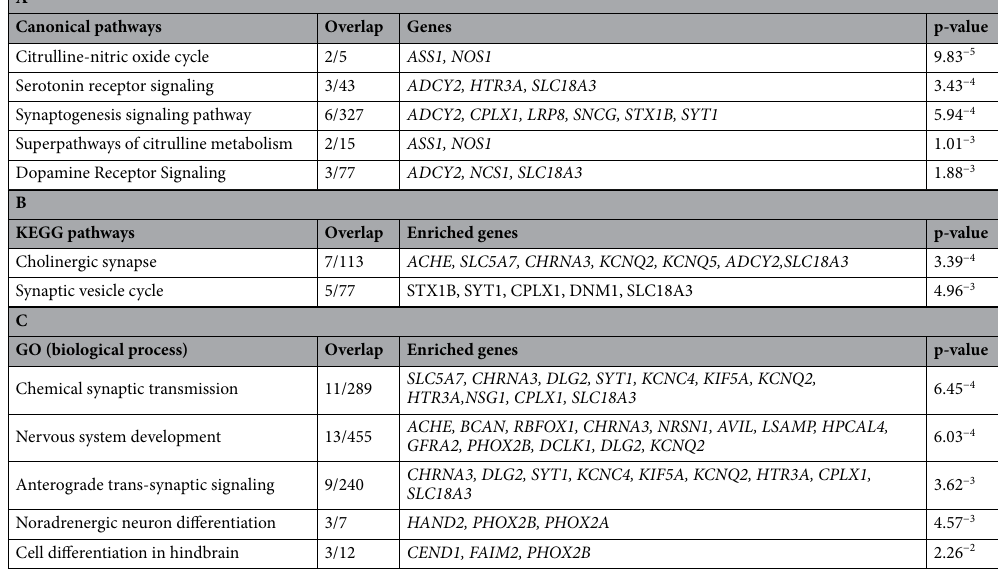
Table 2. Pathway analysis of the 95 differentially expressed genes between islets of pregnancy Prlr +/− and βPrlR +/− mice. (A) Canonical pathways that are differentially expressed in Prlr +/− versus βPrlR +/− mice, as identified by the Ingenuity Pathway Analysis. (B) KEGG pathway analysis of the 95 genes (from Table 1) identified 2 significantly enriched pathways (https:// maaya nlab. cloud/ Enric hr/ enrich#). (C) GO term analysis of the 95 genes (from Table 1) identified 5 significantly enriched